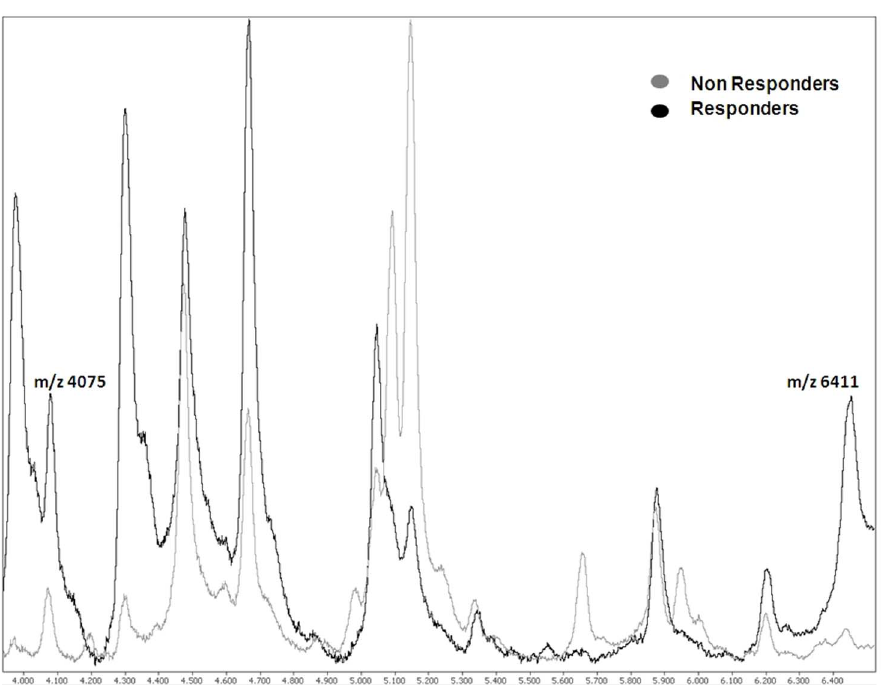
Figure 1. Representative example of fractionated serum protein profiles of two temozolomide/ fotemustine treated patients (from responder and a non-responder patients).